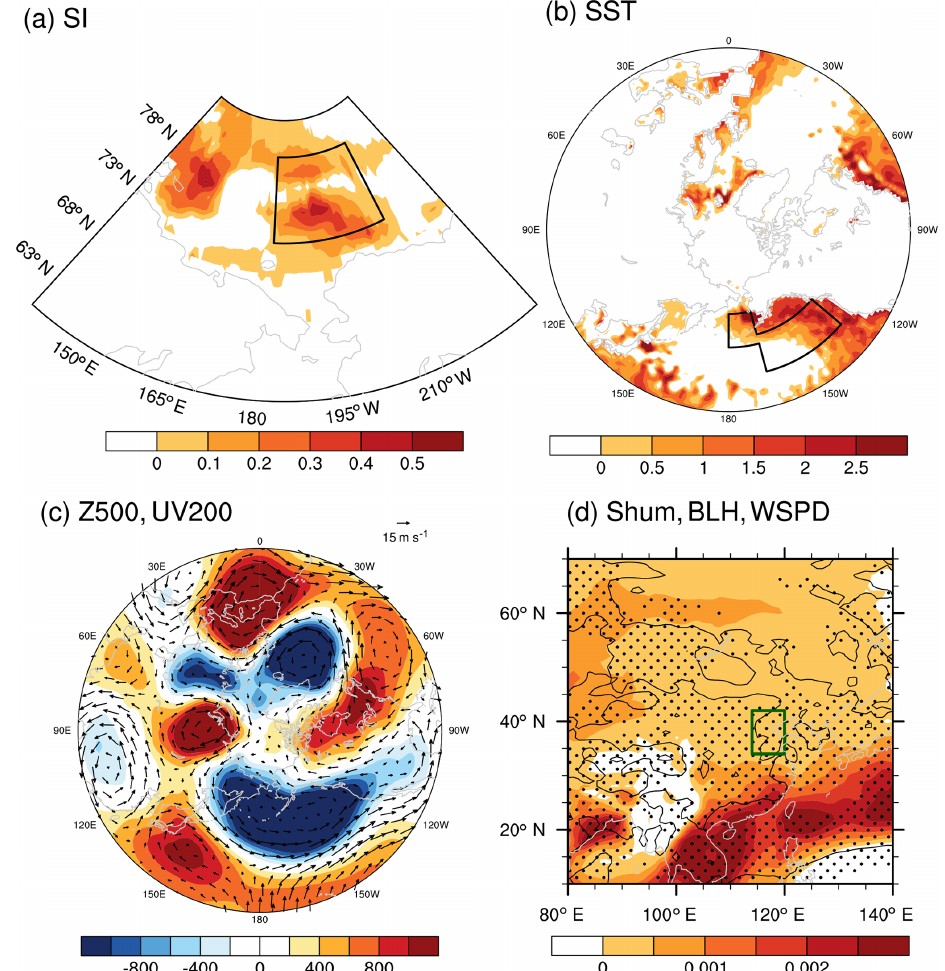
Figure 17. The distributions of (a) September–October sea ice concentration in 2015, (b) sea surface temperature in November 2015, (c) geopotential height (shading) at 500hPa, wind (arrow) at 200hPa in December–January 2015, (d) specific humidity (shading) at 1000hPa, BLH (black dots indicate that its value is negative) and WSPD (contour, solid black lines indicate a negative value) in December–January 2015. The black box in panel (a) represents the location of the Beaufort Sea, and in panel (b) it represents the BA area. The linear trend was